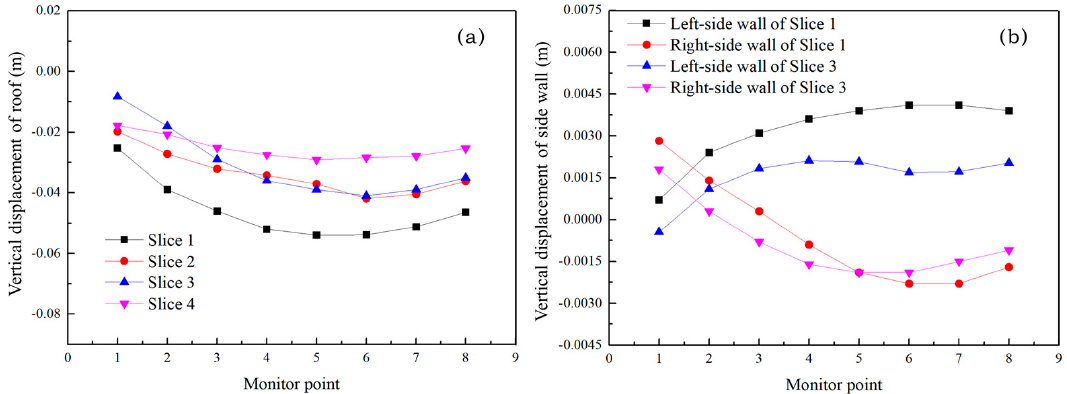
Figure 6. Displacement curve of roof, left- and right-hand side walls of excavated Stope A. ( a ) Vertical displacement of roof; ( b ) Horizontal displacement of side wall.